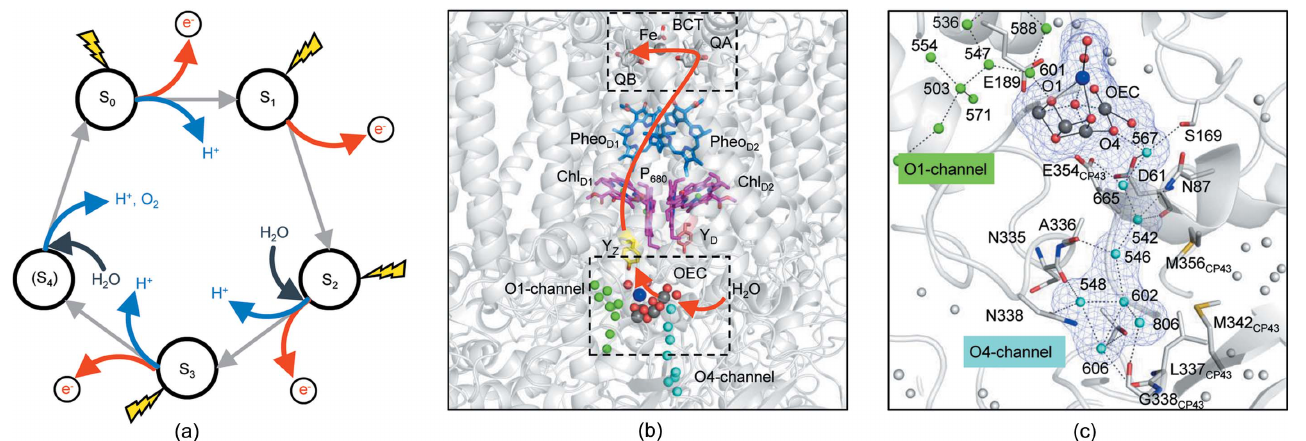
Figure 1 ( a ) S i -state cycle of the water-oxidation reaction of the OEC. ( b ) Electron-transfer chain of PSII. The flow of electrons is indicated by a red line, and the regions around the OEC, Q B and the non-heme iron are boxed with black dashed lines. ( c ) Enlarged views of the boxed region around the OEC shown in ( b ). Water molecules in the O1 and O4 channels are shown as green and cyan spheres, respectively. The light-blue mesh shows the radius of atoms of the OEC and the water molecules in the O4 channel. The Cl1 and Cl2 channels have been omitted for